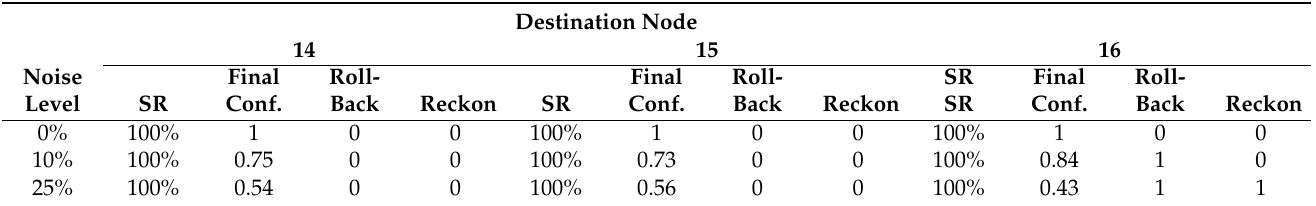
Table 7. Navigation tests for the Kaatiala Mine: Success rate (SR), final value of the confidence index, number rollback, and reckon